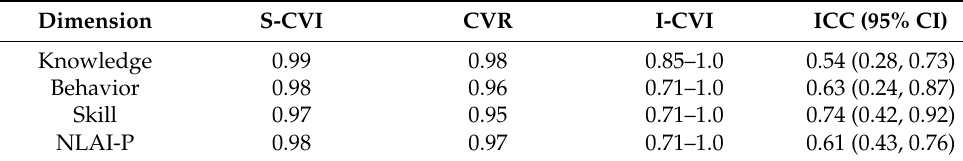
Table 4. The CVI and CVR of each dimension and the whole NLAI-P.